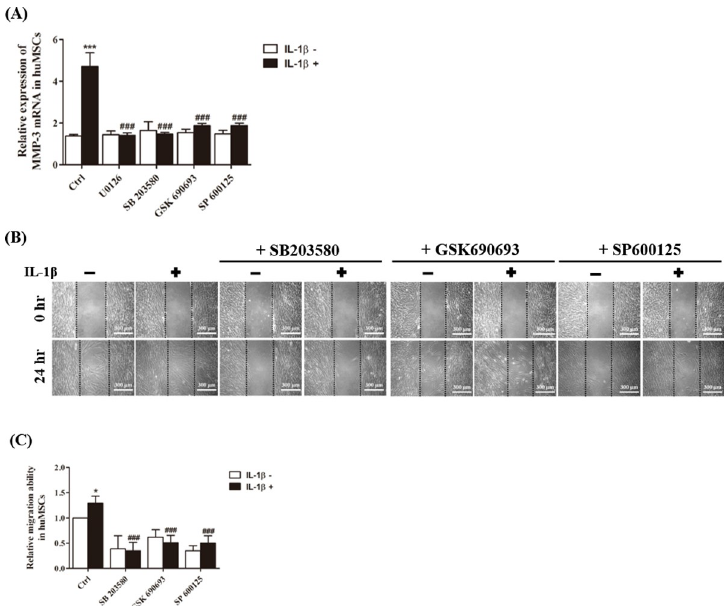
Fig 6. Effects of JNK, p38, and Akt pathways on IL-1 β induced MMP-3 expression on hUCMSCs. (A) Quantitation of changes in gene expression of MMP-3 detected by real-time PCR after p38 inhibitor (50 nM SB205380), Akt inhibitor (20 μ M GSK690693), and JNK inhibitor (20 nM SP600125) treatment and stimulation with IL-1 β for 24 hours. (B) Cell wound healing assay for IL-1 β stimulated mesenchymal stem cells in the presence 50 nM SB205380, 20 μ M GSK690693, and 20 nM SP600125 at 24 hours. Scale bars = 300 μ m. (C) Graph indicates the migration ability of stem cells into the wound area. Data are shown as the mean ± SD (n = 3, � P < 0.05, ��� P < 0.005 versus control cells, ###p < 0.005 versus IL-1 β treated